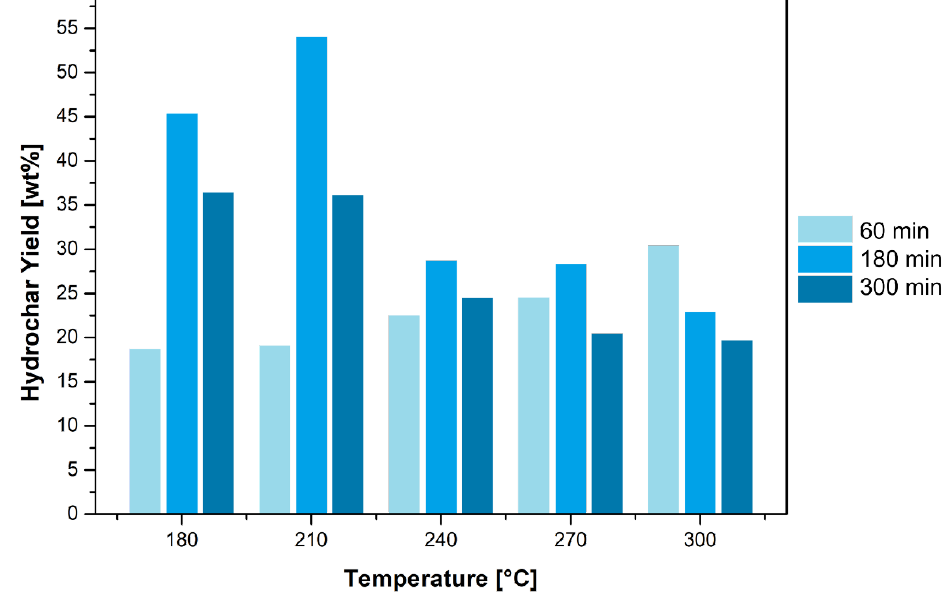
Figure 1. Hydrochar yield as a function of reaction temperature at a fixed reaction time.